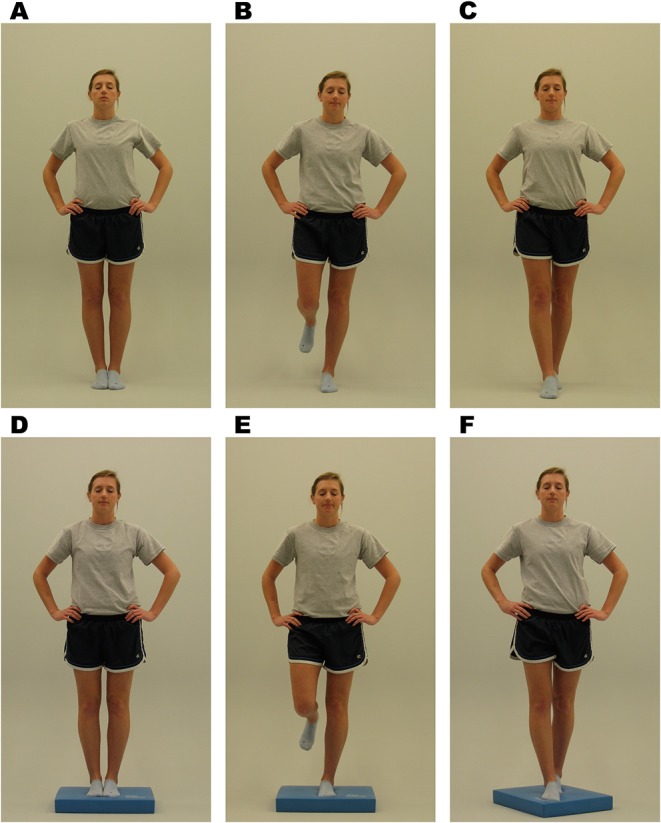
Balance Error Scoring System (BESS) stances. Written informed consent was provided by the individual in the image for publication. (A) Double leg firm, (B) single leg firm, (C) tandem stance firm, (C) double leg foam, (E) single leg foam, and (F) tandem stance foam (29).